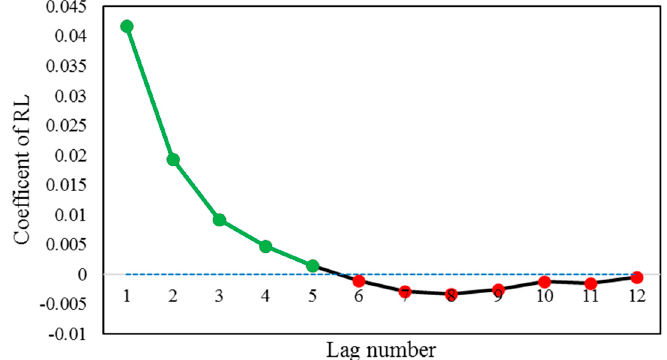
Figure 6. Result of the RF method for the pre-processing of the lake water level data.